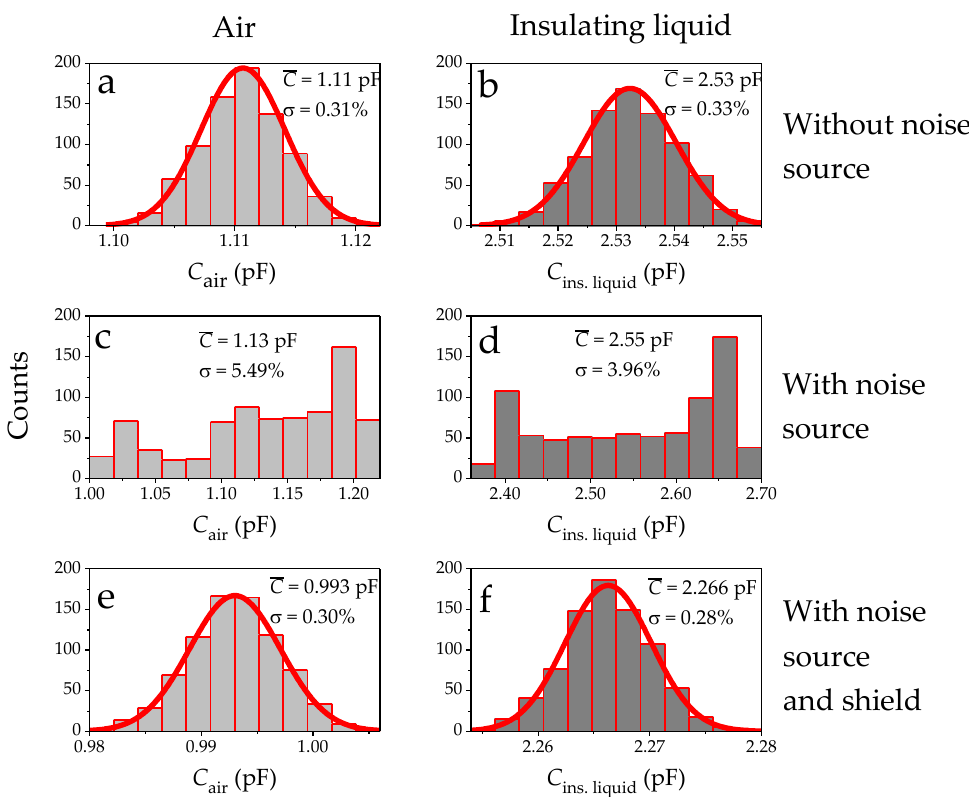
Figure 11. The capacitance values plotted as histograms. Capacitance values without the noise source for media of ( a ) air and ( b ) insulating liquid. Capacitance with the noise source for media ( c ) air and ( d ) insulating liquid. Capacitance with shield and noise source for media ( e ) air and ( f ) insulating liquid. Table 3. Influence of noise source and shield on permittivity for λ = 4 mm. Measurement Mean Value 1 Standard Deviation σ